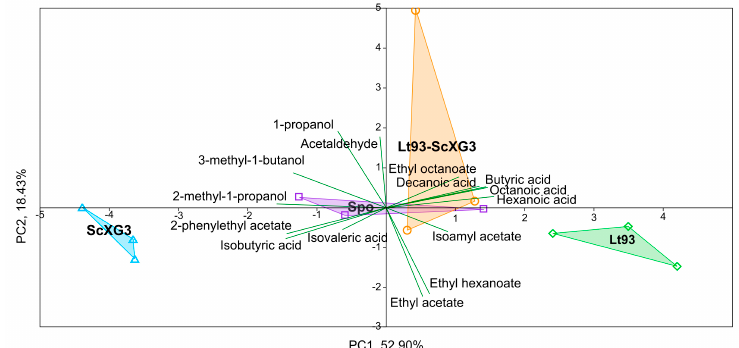
Figure 5. Principal component analysis (PCA) of Treixadura wines: biplot for the first two components (PC) for volatile compounds with OAV > 1. Wines were from fermentation with the following yeasts: ScXG3— S. cerevisiae ScXG3; Lt93— L. thermotolerans Lt93; Lt93—ScXG3- L. thermotolerans Lt93 and sequential inoculation of S. cerevisiae ScXG3; Spo: spontaneous fermentation.